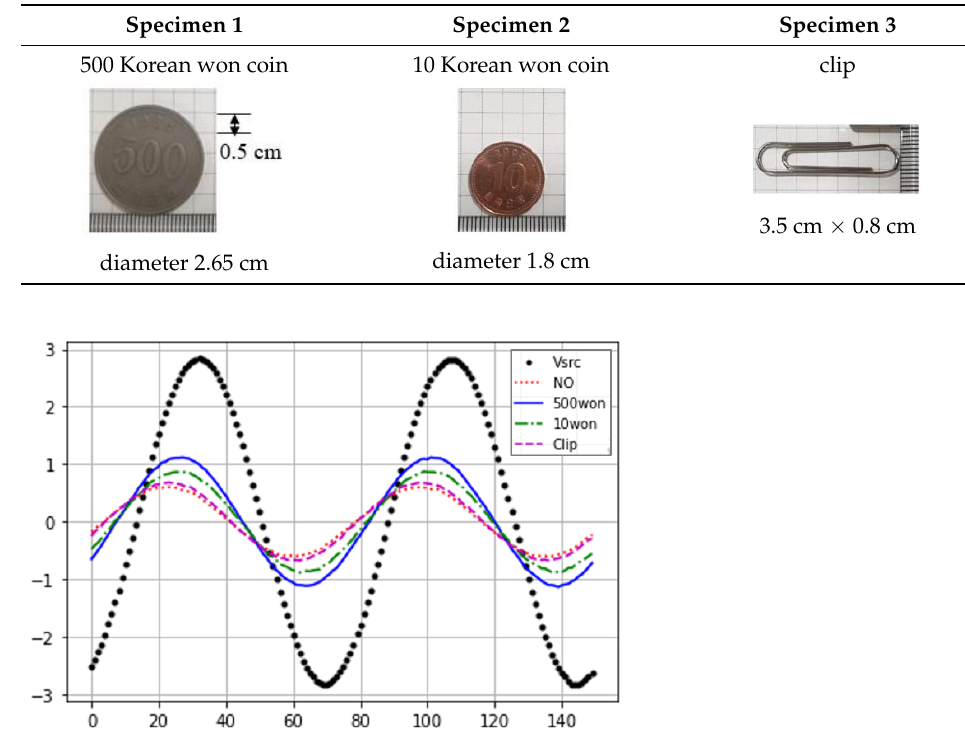
Figure 8. Measured voltage signals.